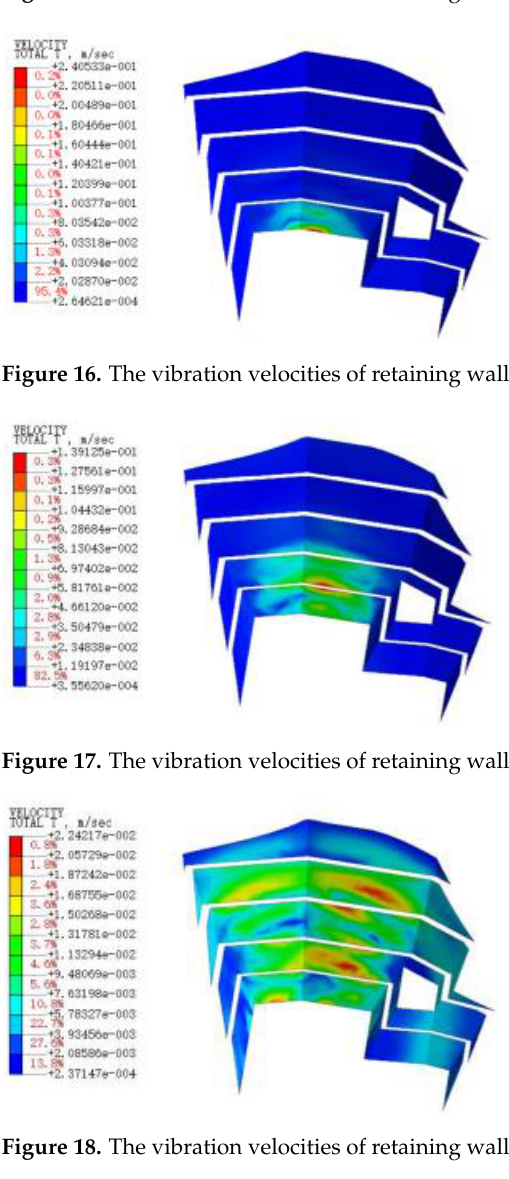
Figure 19. The vibration velocities of retaining walls at 500 ms.